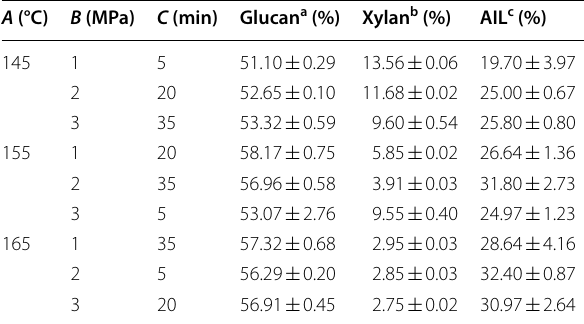
Table 3 The three components yield of sugarcane bagasse after SCSP of orthogonal experiment